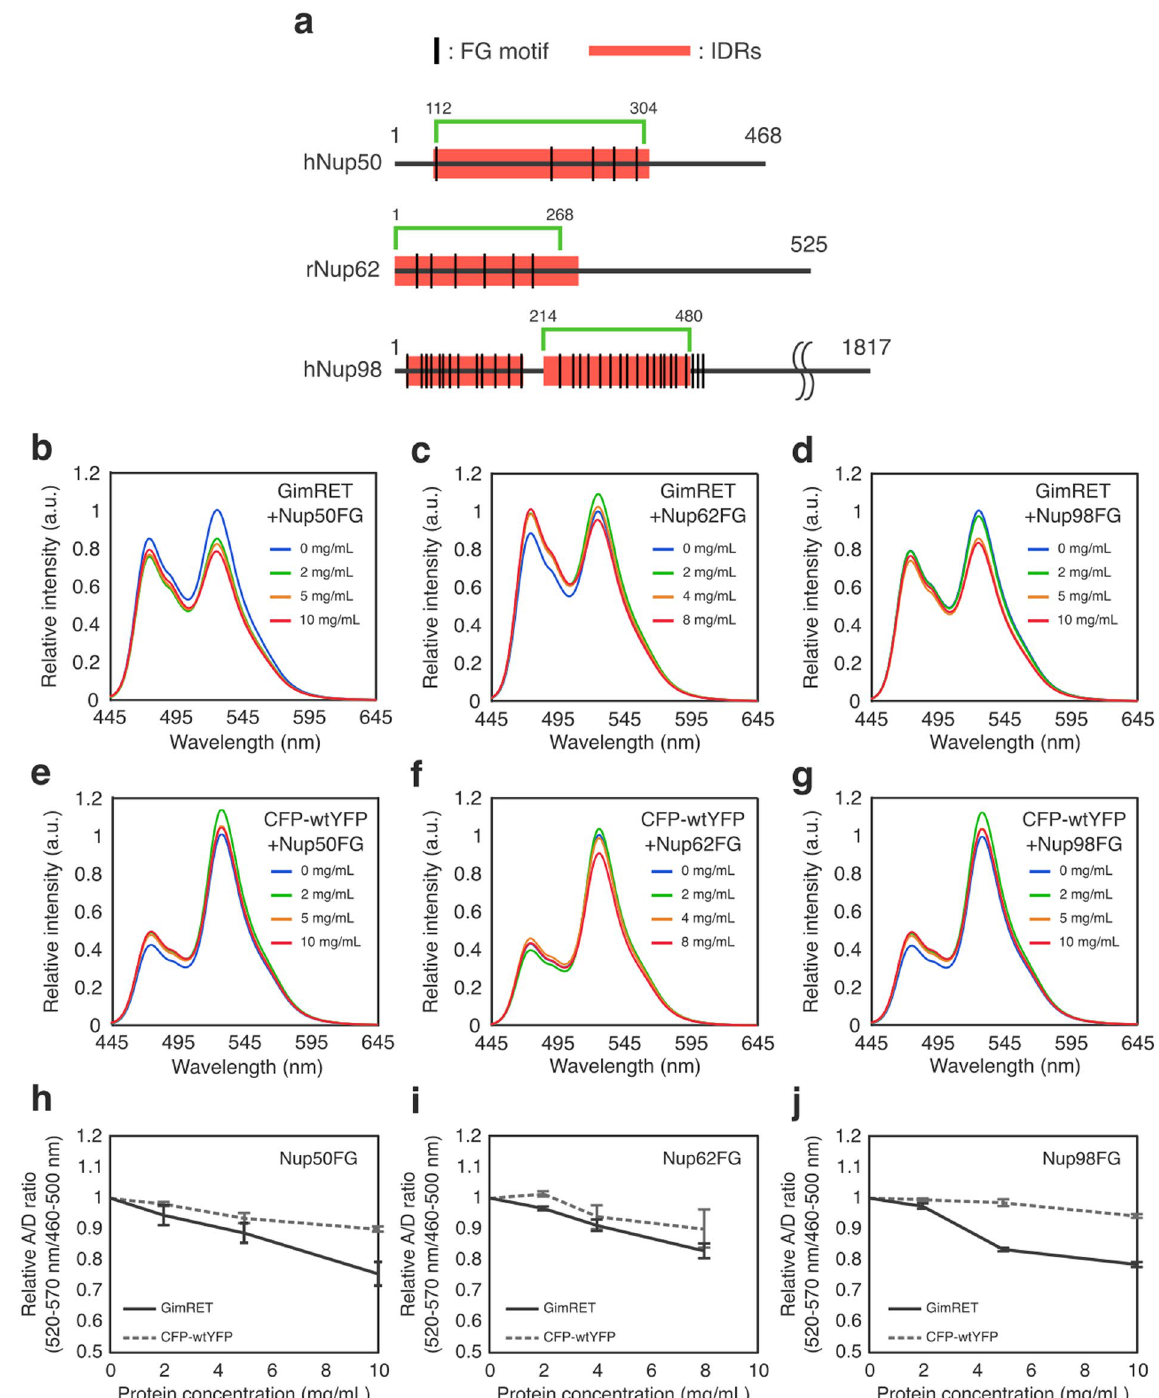
Figure 1. GimRET senses crowding of Nups. ( a ) Schematic representation of FG-fragments used in the probe assay. The regions for FG-fragments used in in vitro crowding assay are shown in green. Intrinsically disordered regions (IDRs) predicted by PONDR algorithm are shown with red bar. UniProtKB accession numbers for sequence prediction: Q9UKX7, hNup50; P17955, rNup62; P52948, hNup98. ( b–g ) Fluorescence spectra of purified GimRET ( b–d ) and CFP-wtYFP ( e–g ) in the presence of different concentrations of FG-fragments (Nups50 ( b and e ), Nup62 ( c and f ), and Nup98 ( d and g )). Emission spectra with excitation wavelengths of 433 nm are shown. Concentrations of Nups were as follows: 0 mg/mL, blue; 2 mg/mL, green; 5 mg/mL, orange; 10 mg/mL (8 mg/mL for Nup62FG), red. ( h–j ) Acceptor/donor (A/D) ratios from GimRET (solid line) and CFP-wtYFP (dotted line) are plotted against Nup concentration, Nup50FG ( h ), Nup62FG ( i ) and Nup98FG ( j ). Data are presented as mean ± SD, from three independent